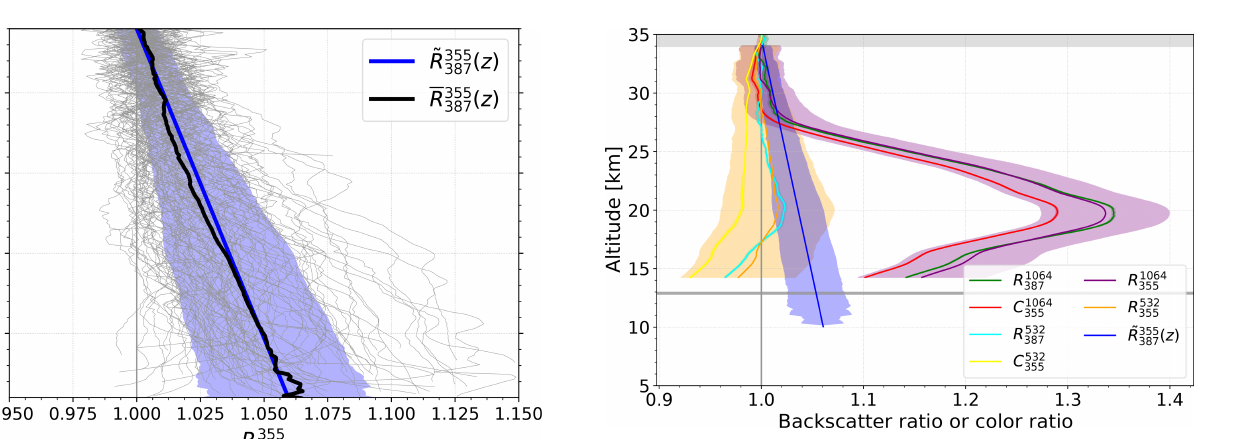
Figure 5. Backscatter ratios R 355 the period 2000 to 2018. Each gray line represents the mean of the measurement run. The total measurement time is 1789h. R the mean of all profiles, and e R 355 shaded area represents the standard deviation of the R 355